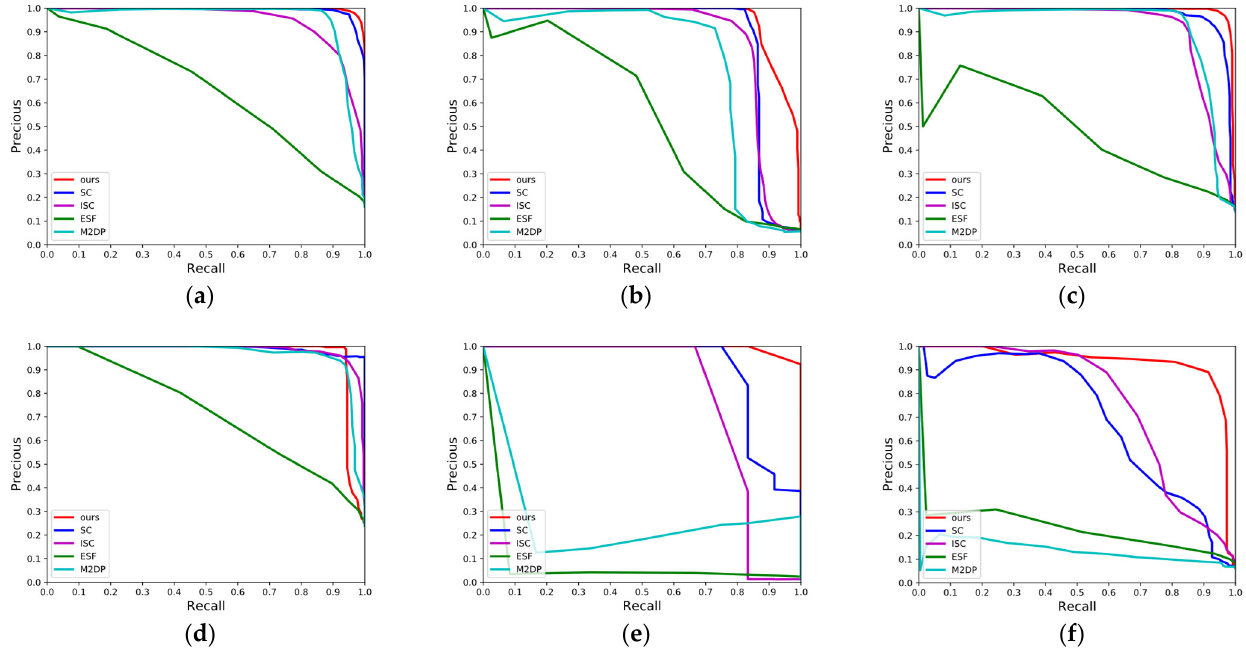
Figure 6. P-R curves of different methods over the dataset KITTI. ( a ) KITTI 00; ( b ) KITTI 02; ( c ) KITTI 05; ( d ) KITTI 06; ( e ) KITTI 07; ( f ) KITTI